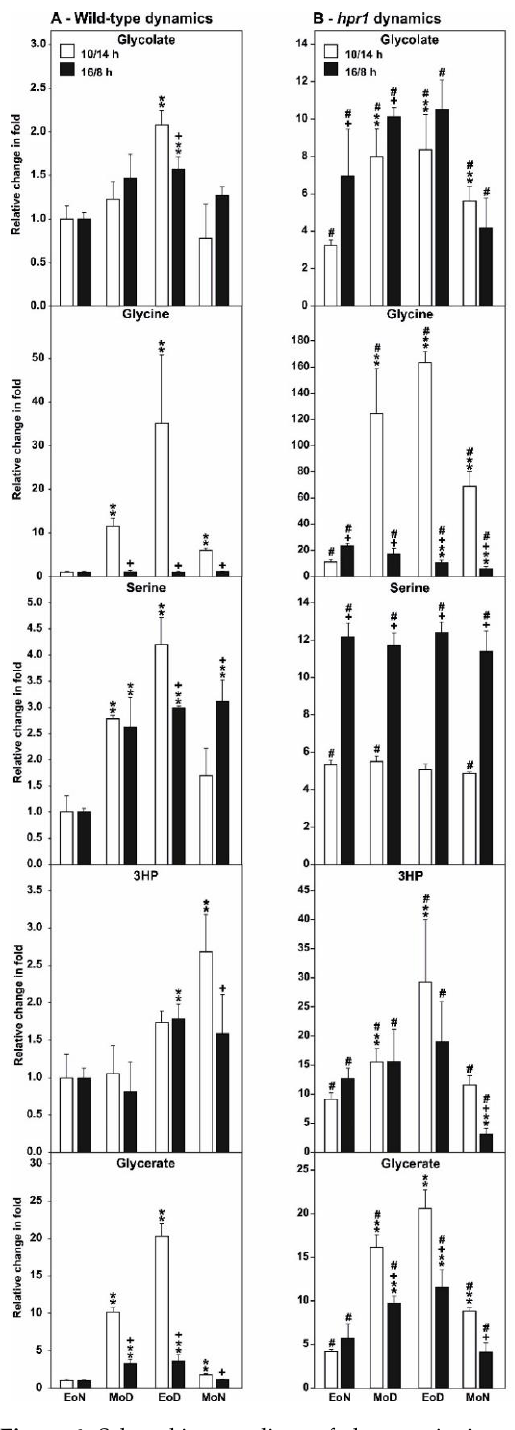
Figure 6. Selected intermediates of photorespiration of plants grown under two different photoperiods. Shown are relative amounts of selected photorespiratory intermediates form air grown wild-type and hpr1 mutant plants in two photoperiods (SD—10/14 h day/night cycle, and LD—16/8 h day/night cycle) with otherwise equal conditions. Plants were grown to growth stage 5.1 [41] and metabolites determined at four diagnostic timepoints during the day/night cycle (end of night (EoN), mid of day (MoD), end of day (EoD) and mid of night (MoN)). Shown are means ± SD (five biological replicates) with the wildtype EoN time point was arbitrary set to 1. Asterisks show significant changes compared with the wild-type EoN timepoint, plusses indicate significant changes between SD and LD and rhombus indicate significant changes at the respective timepoint between the wild type and hpr1 according to Student’s t -test (** p < 0.01). The figure was redrawn, using data that were in part previously published [35], with permission